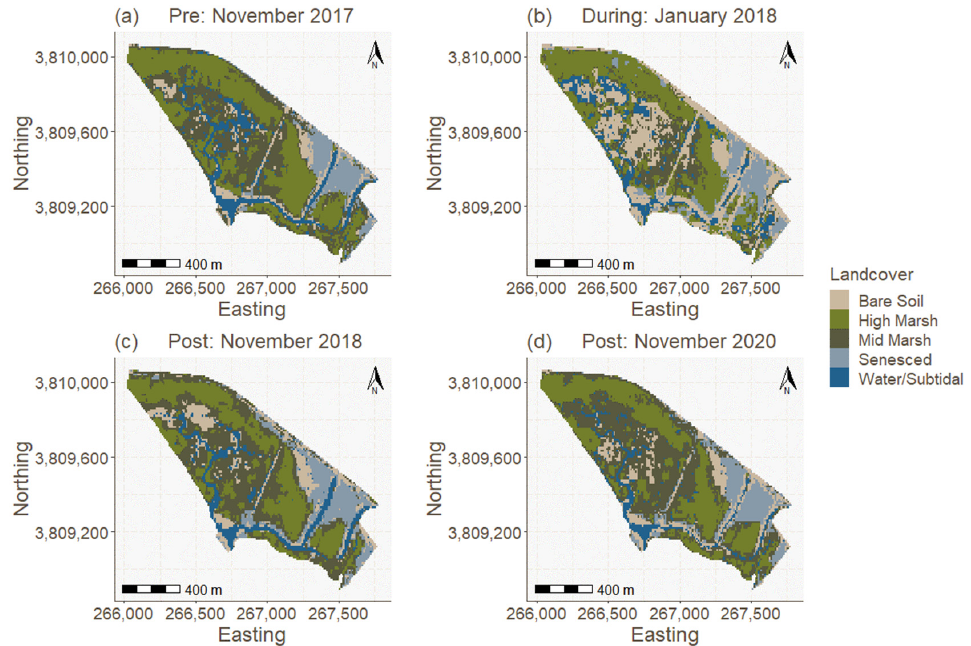
Figure 4. Maps produced by the random forest classification. Maps depict the extent of bare soil, high marsh, mid marsh, senesced vegetation, and subtidal/water landcover. Top to bottom, left to right: ( a ) November 2017, ( b ) January 2018, ( c ) November 2018, and ( d ) November 2020. (Projection: NAD 84 UTM Zone 11).